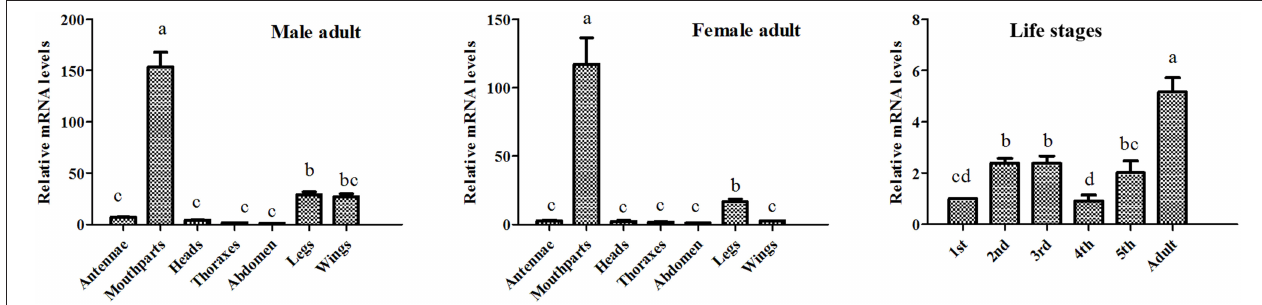
FIGURE 3 | The relative transcript levels of AlinOBP11 at different developmental stages and adult tissues of both sexes analyzed by qRT-PCR. All data were normalized to endogenous house-keeping genes Alin β -actin (GenBank No. GQ477013) and relative fold changes are normalized to transcript level of the first instar nymph or abdomen. The error bars represents the standard errors, and the different letters a, b, c, and d indicate significant differences ( p < 0.05 ) among different samples. The similar results were obtained with AlinElongation factor (GenBank No. AEY99651) as internal control ( Figure S2 ).